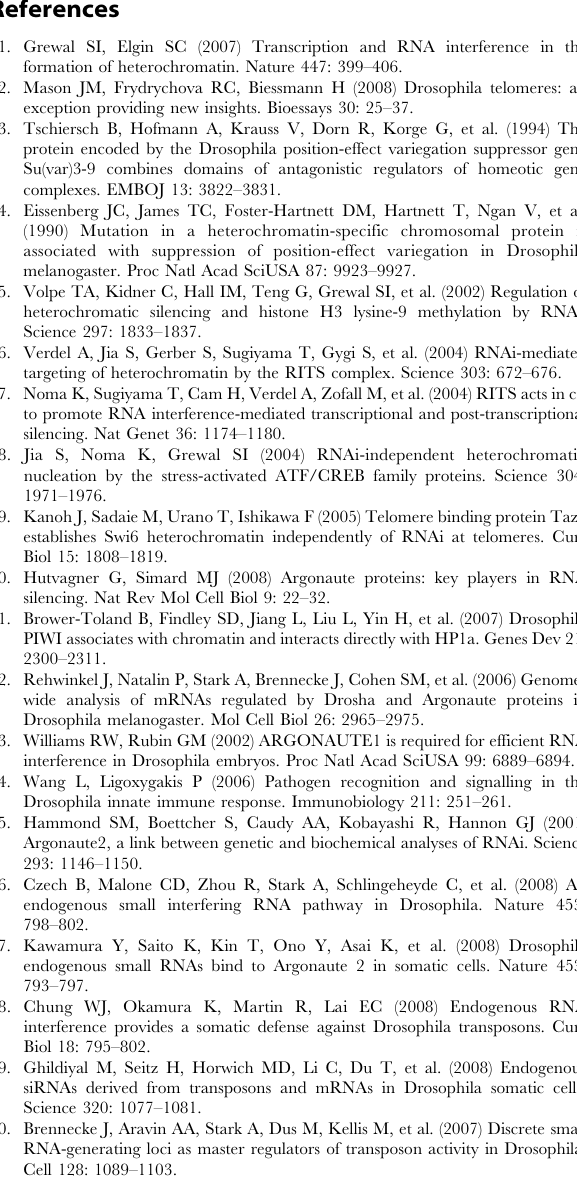
Table S2 Primer set sequences used for ChIP at the 80EF piRNA cluster. Found at: doi:10.1371/journal.pgen.1000880.s010 (0.05 MB DOC) Text S1 Detailed ChIP